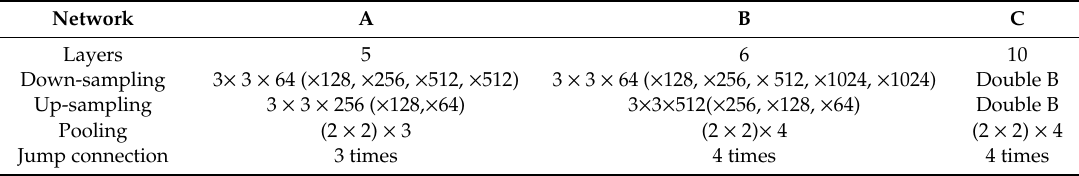
Figure 2. Three designed U-net model structures. Table 3. Comparison of model hyper-parameters.